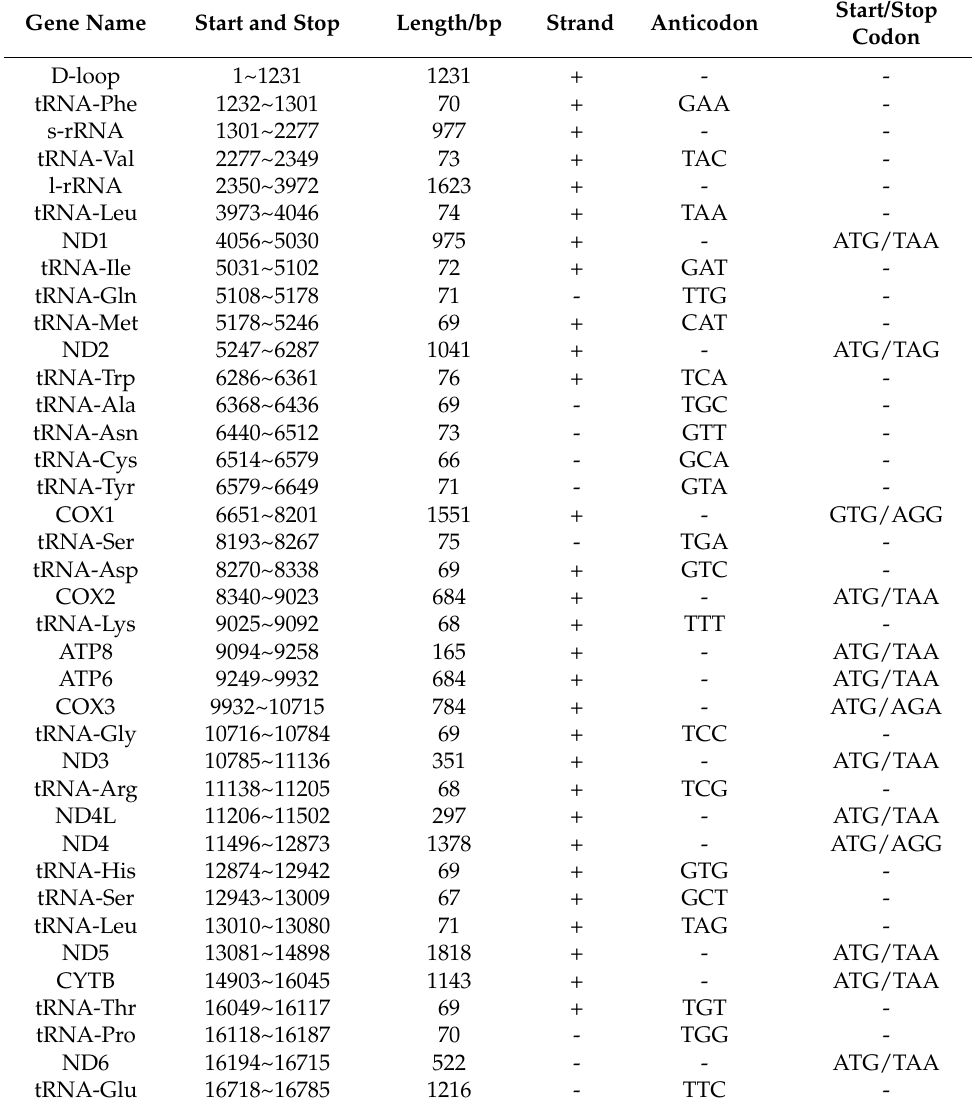
Table 1. Organization of the Pingpu Yellow chicken